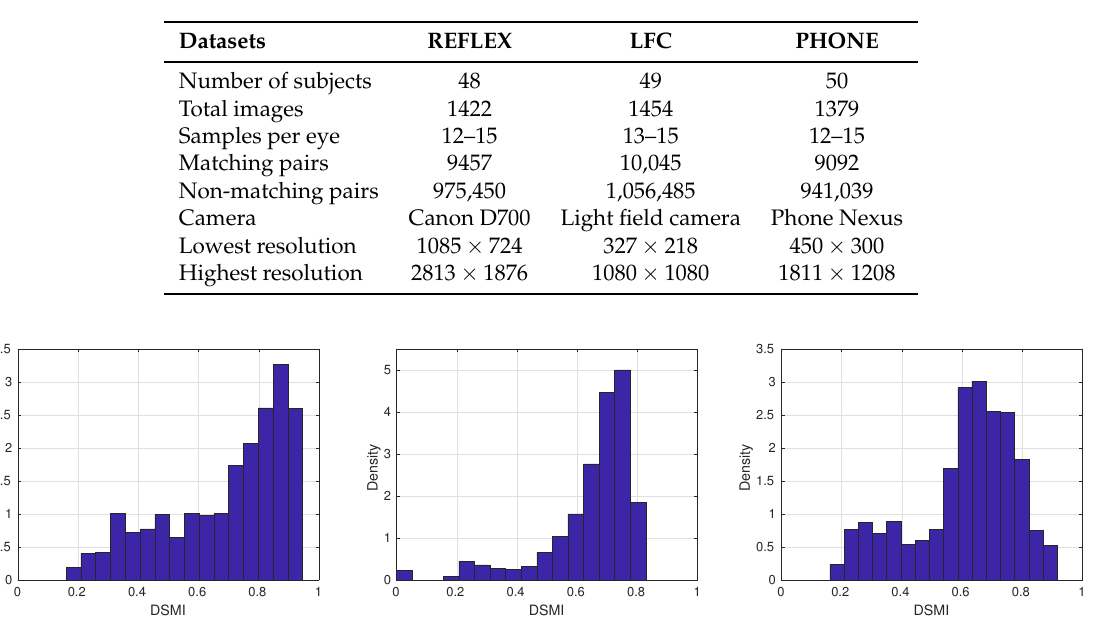
Table 2. Summary of the GC 2 dataset.